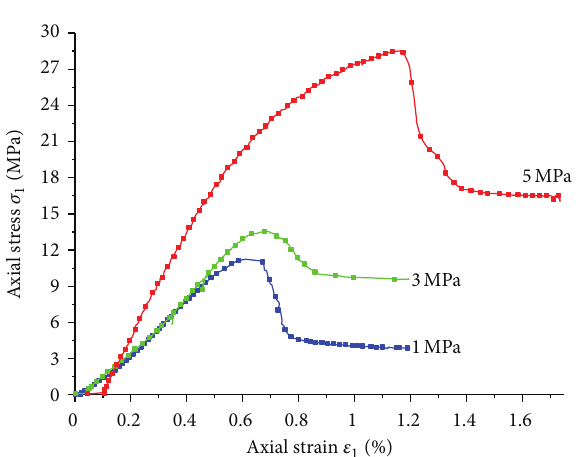
Figure 8: Stress-strain relations of coal samples under triaxial compression.